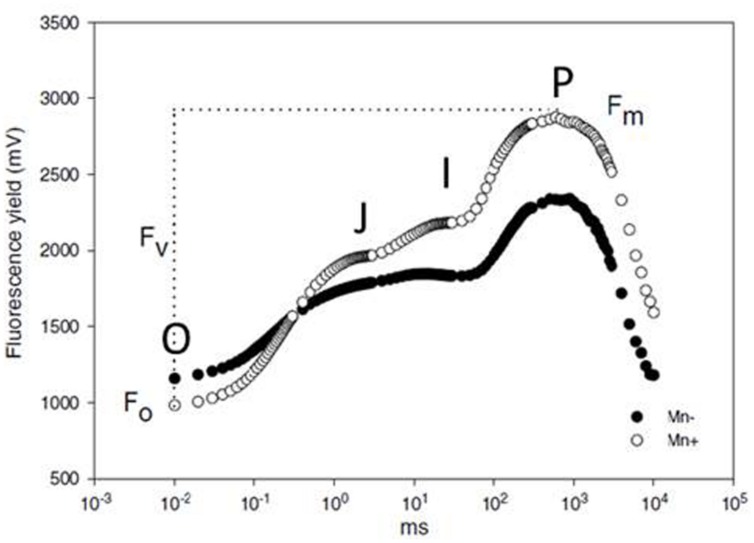
The OJIP transients of chlorophyll fluorescence for Mn deficient (black circles) and Mn sufficient (open circles) barley plants at the booting growth stage. From Hebbern et al. (2005).